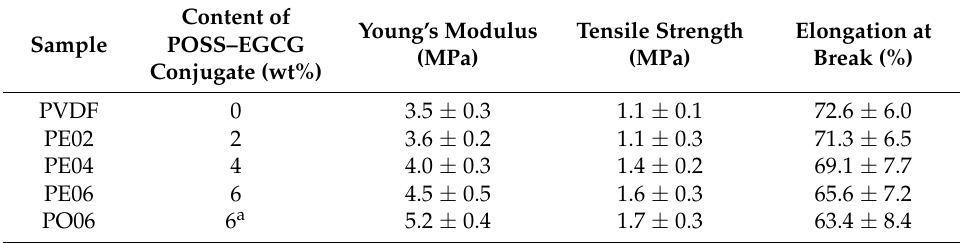
Table 1. Mechanical properties of the PVDF composite nanofibers with different contents of the POSS–EGCG conjugate.